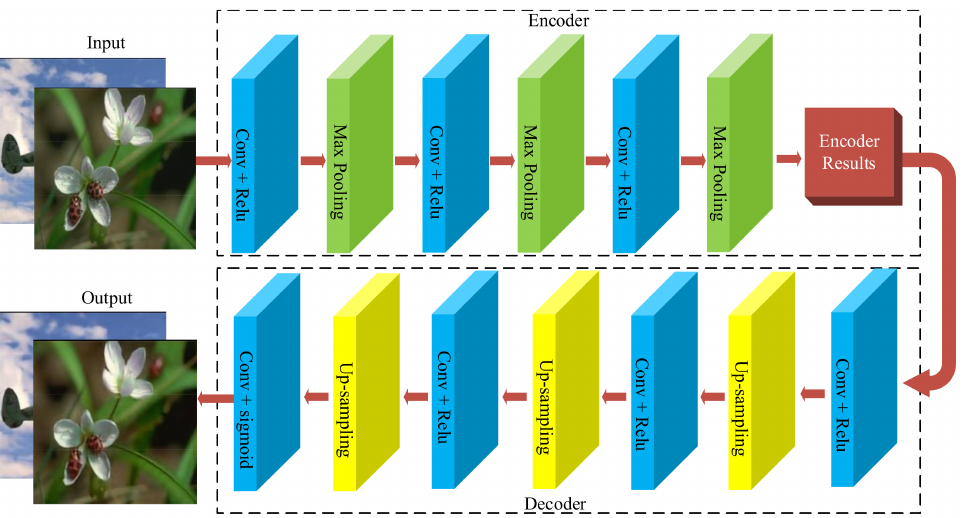
Figure 1. Classical model of a convolutional auto-encoder